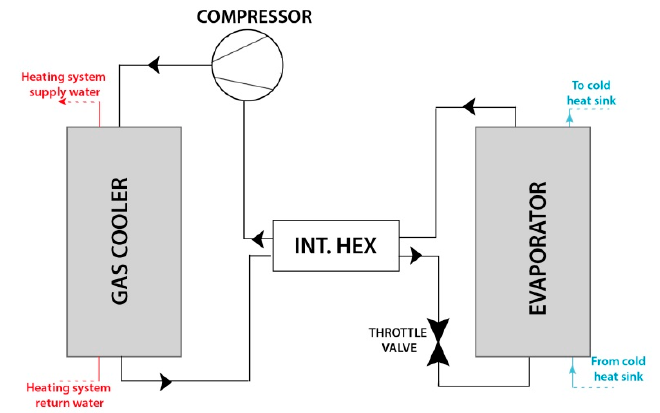
Figure 6. Transcritical CO 2 heat pump layout.